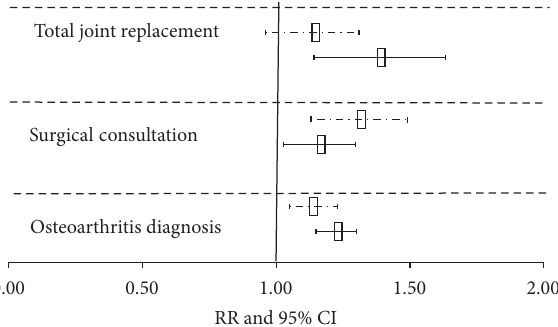
Figure 1: Adjusted relative risk (RR) and the 95% confidence interval (CI) of diabetes according to the severity of osteoarthritis. Box-plots with solid line represent cases of age 20–64 years and dash line represents cases of age 65 years and over. RRs were adjusted for age,sex,bodymassindex,socioeconomicstatus,chronicobstructive pulmonary disease, hypertension, hyperlipidemia, and Charlson